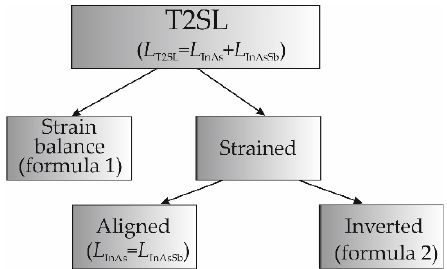
Figure 3. Scheme for determining the thickness of the tested T2SLs.